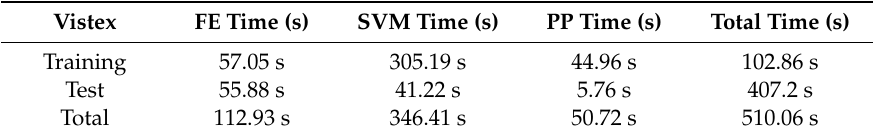
Table 10. Computational time of the proposed method on feature extraction (FE), SVM classification time, postprocessing (PP) time and total time. Experiments were conducted on the Vistex database (54